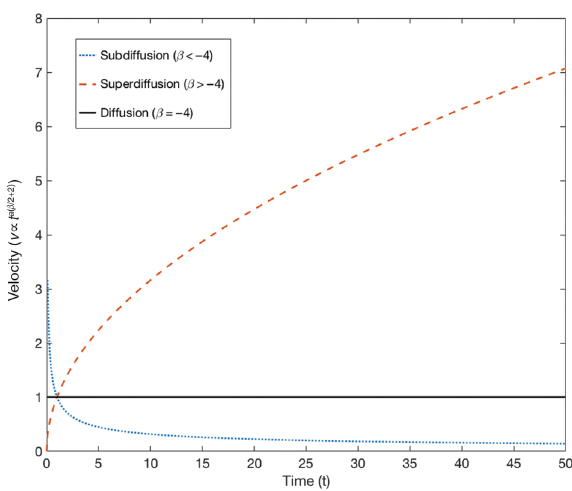
Figure 4: The LEUP compliance β controls the different regimes of cell